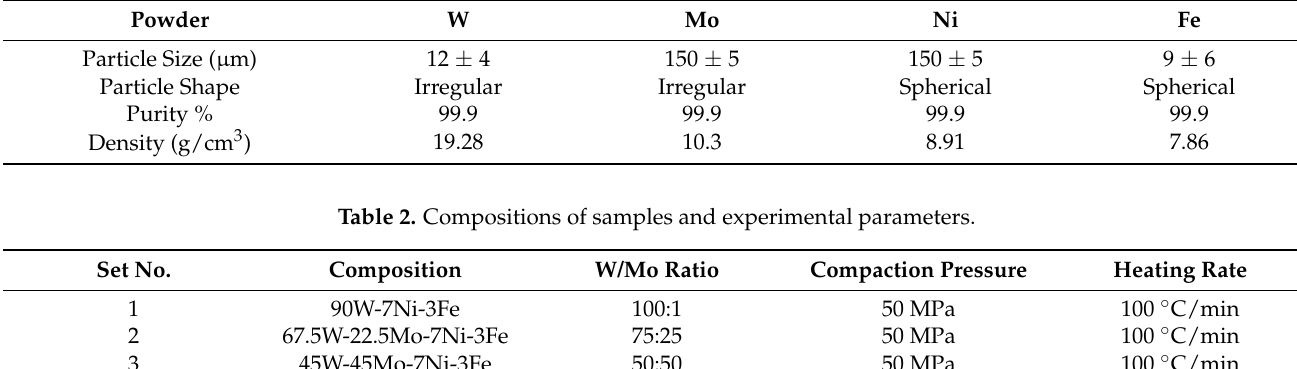
Table 1. Characteristics of W, Mo, Ni, and Fe metal powders.